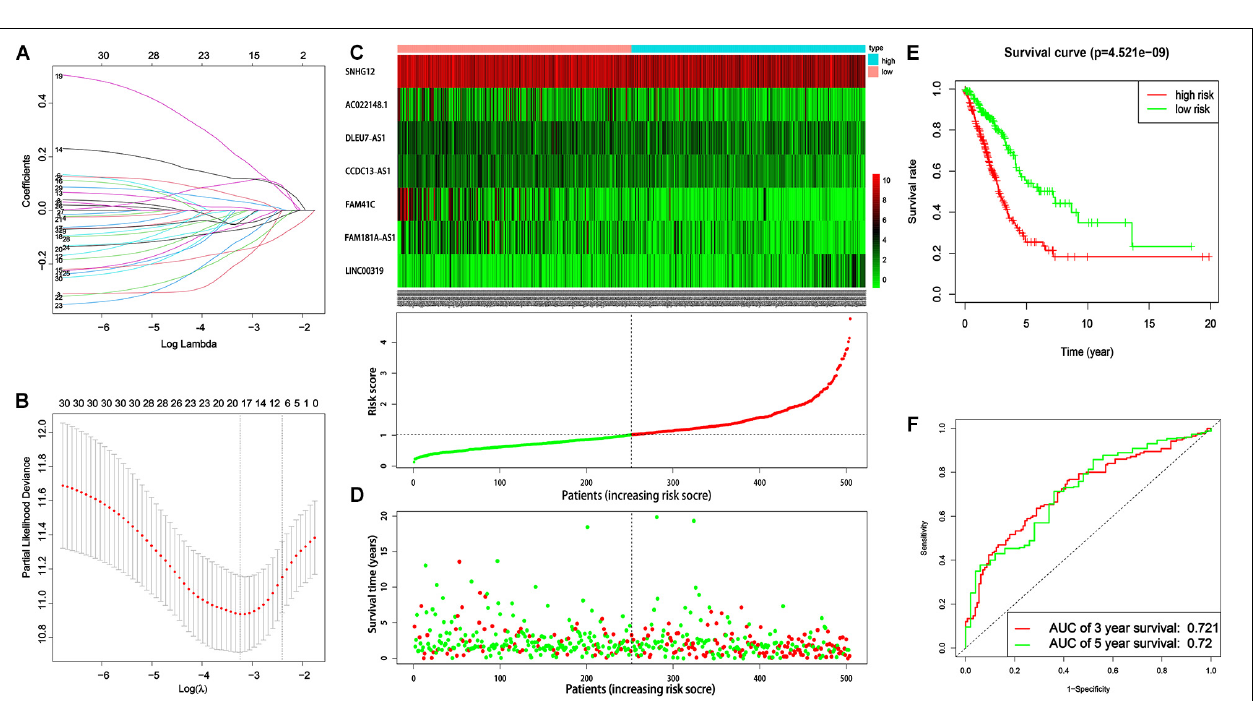
FIGURE 4 | The lncRNA-based prognostic signature for LUAD. (A) The convergence of the lasso-based variable selection with the log of the penalty parameter lambda ( λ ). (B) The changes of model fitting statistic, partial likelihood deviance, and its range, obtained from 10-fold cross-validation. (C) The expression patterns (heat maps) of the seven lncRNAs for patients of two groups (low-risk group, type low and high-risk group, type high). (D) The dot plot of survival time for patients sorted by the lncRNA-based risk score. Red dots indicate death events while green ones survivals. (E) Kaplan–Meier curves for patients of two categories (low-risk groups versus high-risk groups) defined by the lncRNA-based prognostic signature. (F) ROC analysis of the lncRNA-based prognostic signature to estimate AUC values of survival over two different periods.